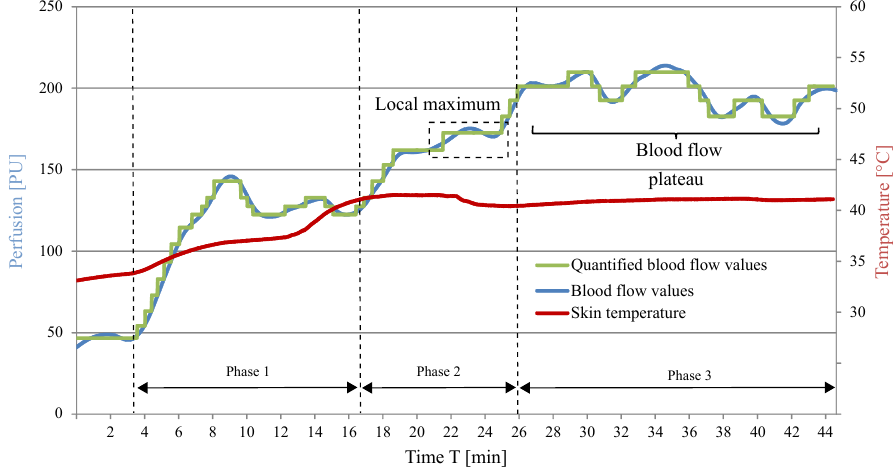
Figure 16. Measured blood flow curve using the function-integrative